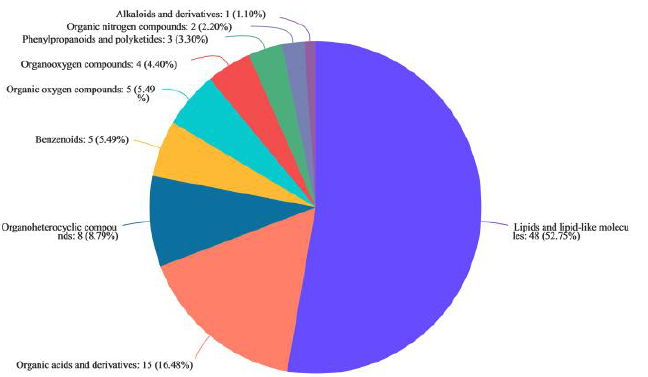
Figure 3. Classification of differential metabolites in the supernatant of the Xenorhabdus bovienii ferment. Further, we screened the differential metabolites that showed a large difference in Table 1. Main differential